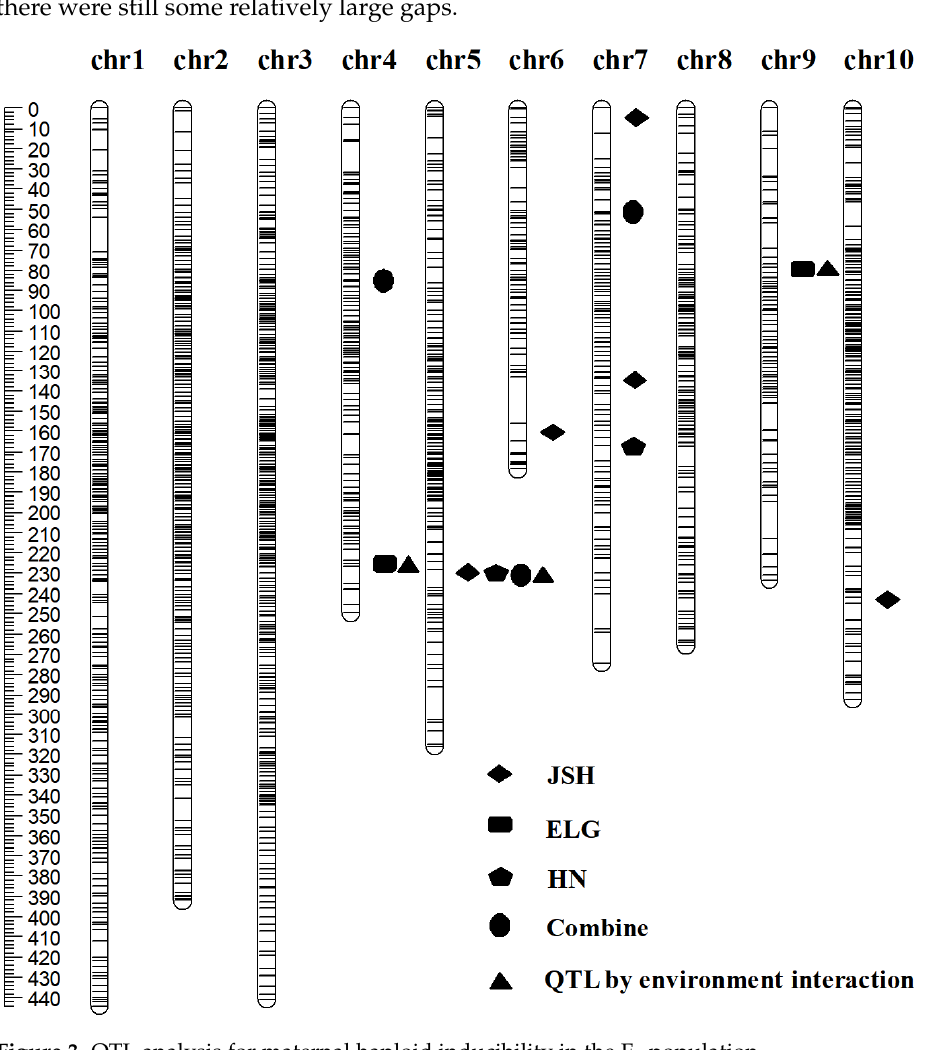
Figure 3. QTL analysis for maternal haploid inducibility in the F 2 population.